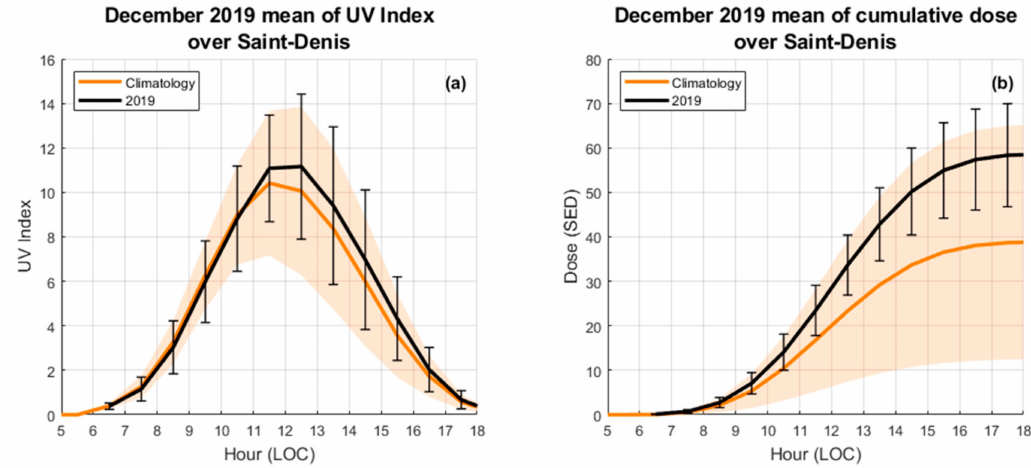
Figure 4. ( a ) represents a comparison of UVI between the December 2019 mean (black) and the December climatological mean (orange) at Saint-Denis; ( b ) represents a comparison of the cumulative exposure dose (SED) between the December 2019 mean (black) and the December climatological mean (orange) over Saint-Denis derived from UVI data ( a ). The orange lines represent the December climatological mean and the shaded areas one standard deviation as derived from 2009–2019 observations. The black lines represent the December 2019 mean and the vertical black bars one standard